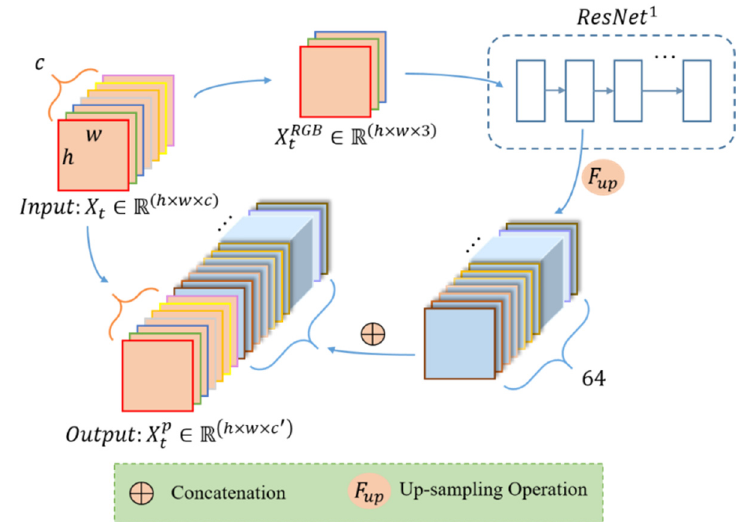
Figure 2. The process of the pretrained model for each image.